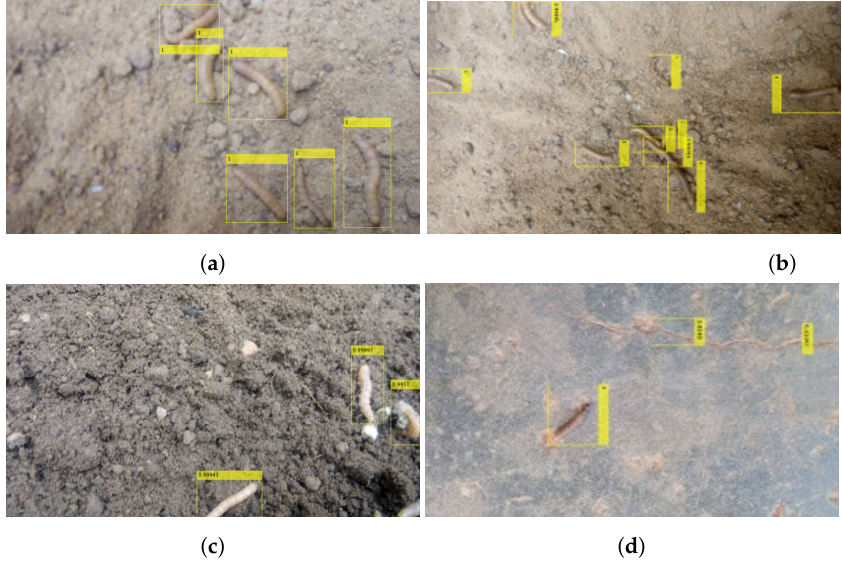
Figure 10. Images of successfully ( a – c ) and wrongly ( d ) detected insects using our proposed faster- RCNN insect